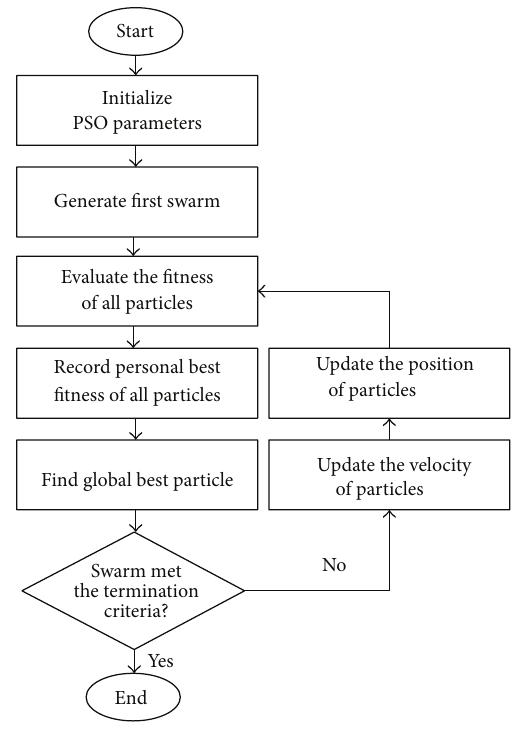
Figure 1: Standard flowchart of